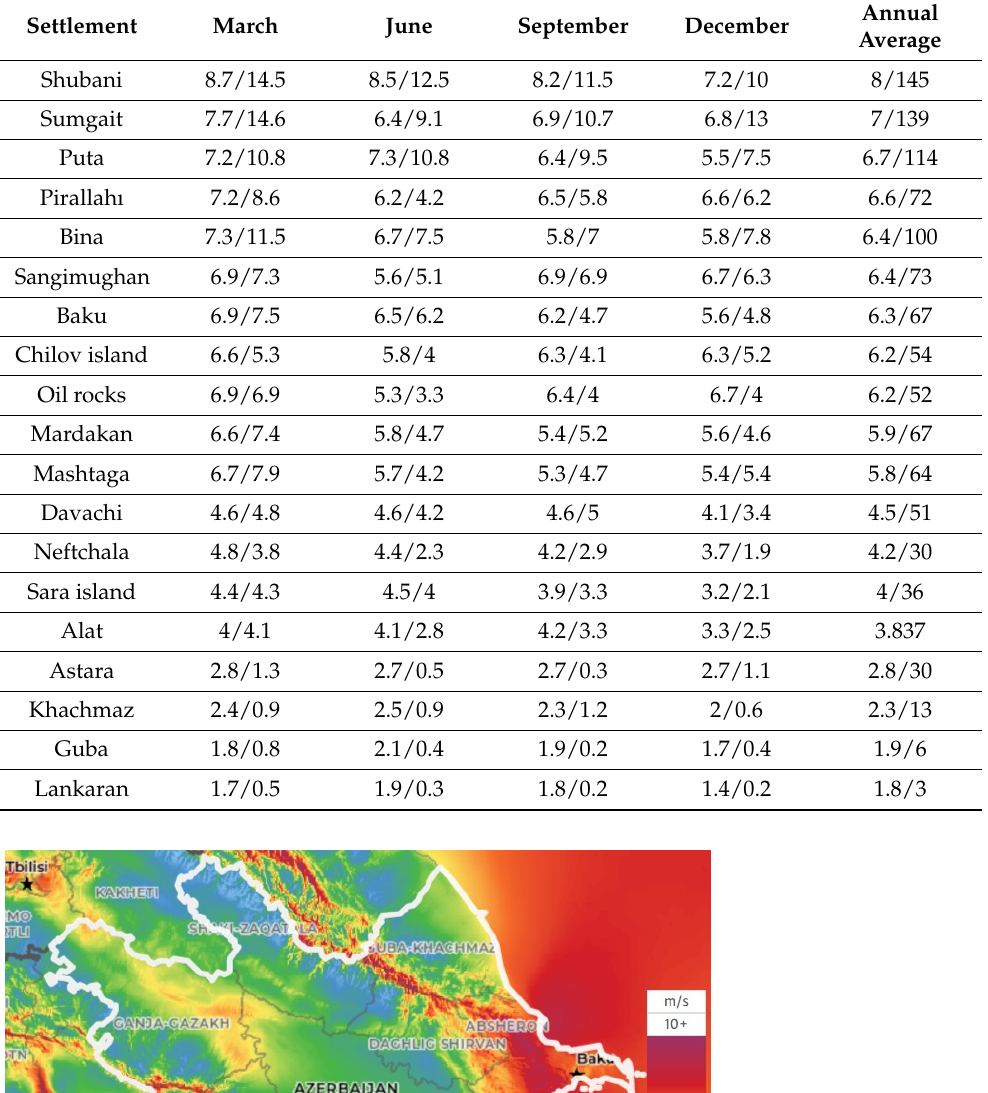
Table 11. Average annual wind speed (in m/s) and number of windy days [7].